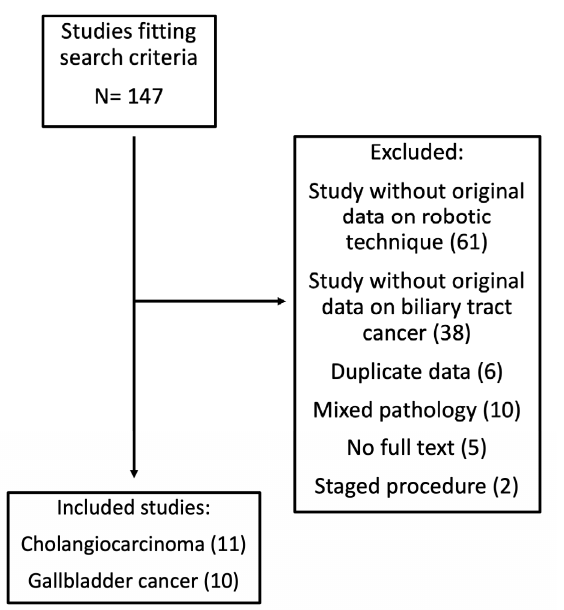
Figure 1. PRISMA flow diagram of study selection process. In total, 20 unique studies were selected, with 1 study meeting the selection criteria for both cholangiocarcinoma and gallbladder cancer.